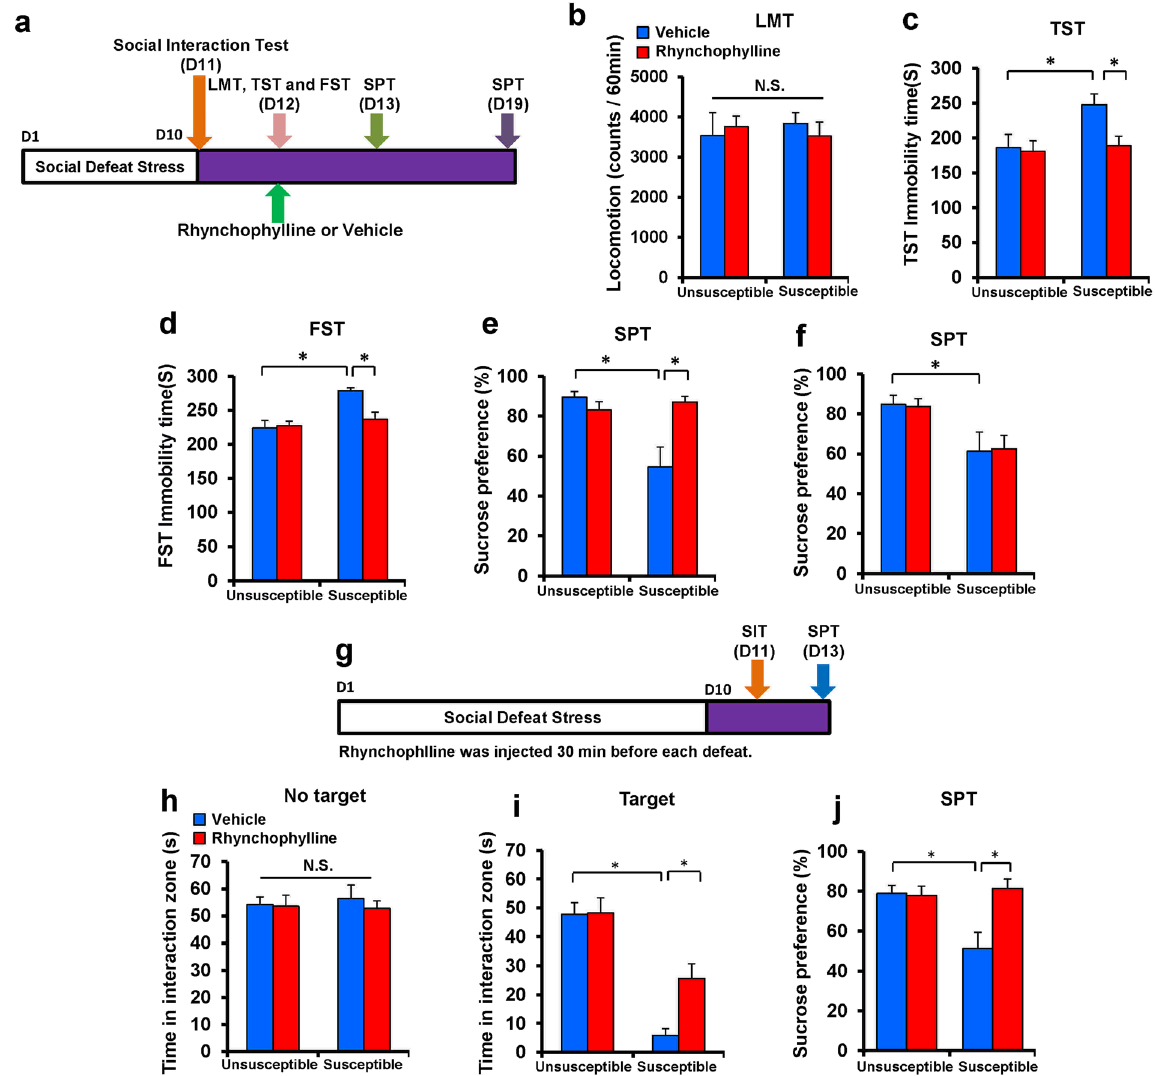
Figure 2. Rhynchophylline had antidepressant and prophylactic effects in a social defeat stress model (8–10 weeks old). ( a ) Schedule of social defeat stress (10 days), drug treatment, and behavioral tests. ( b ) Locomotion test (LMT). ( c ) Tail suspension test (TST). ( d ) Forced swimming test (FST). ( e ) 1% Sucrose preference test (SPT). ( F ) 1% SPT. The values represent the mean ± S.E.M. (n = 14 or 15). * P < 0.05, compared with the vehicle + stressed group. N.S.: not significant. ( g ) Schedule of social defeat stress (10 days), drug treatment, and behavior tests. ( h ) Social interaction test (SIT): no target. ( i ) SIT: target. ( j ) SPT. The values represent the mean ± S.E.M. (n = 8). * P < 0.05 compared with the vehicle + stress group. N.S.: not